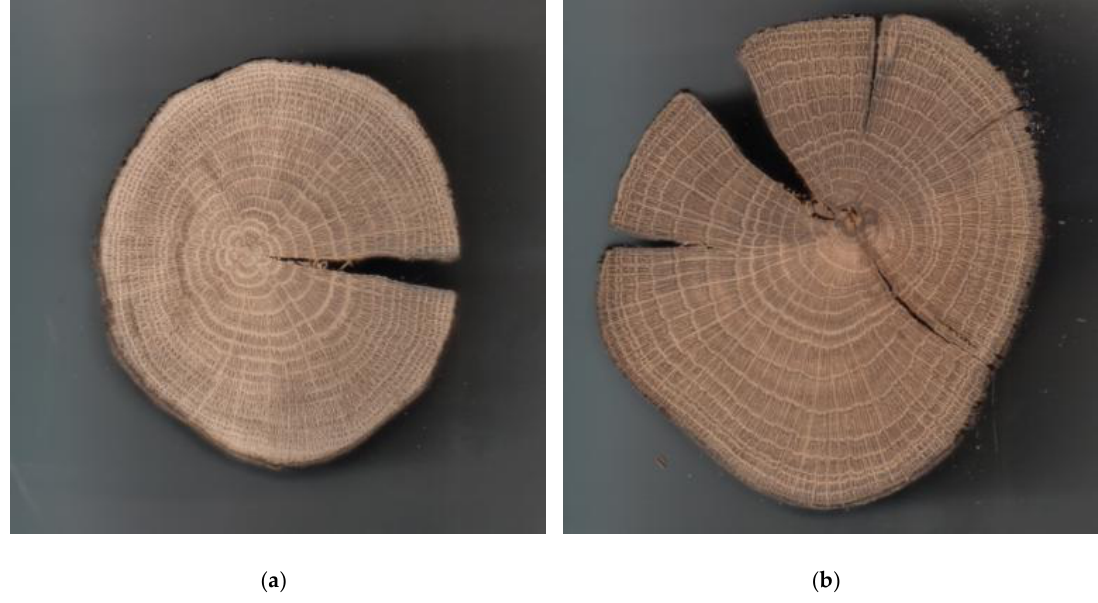
Figure 1. Full cross sections of typical oak wood samples taken from section KRW2 of the forest road in Rogóźno Forest District of the Koło Forest Inspectorate: ( a ) sample no. Db4-KRW2, ( b ) sample no. Db5-KRW2.